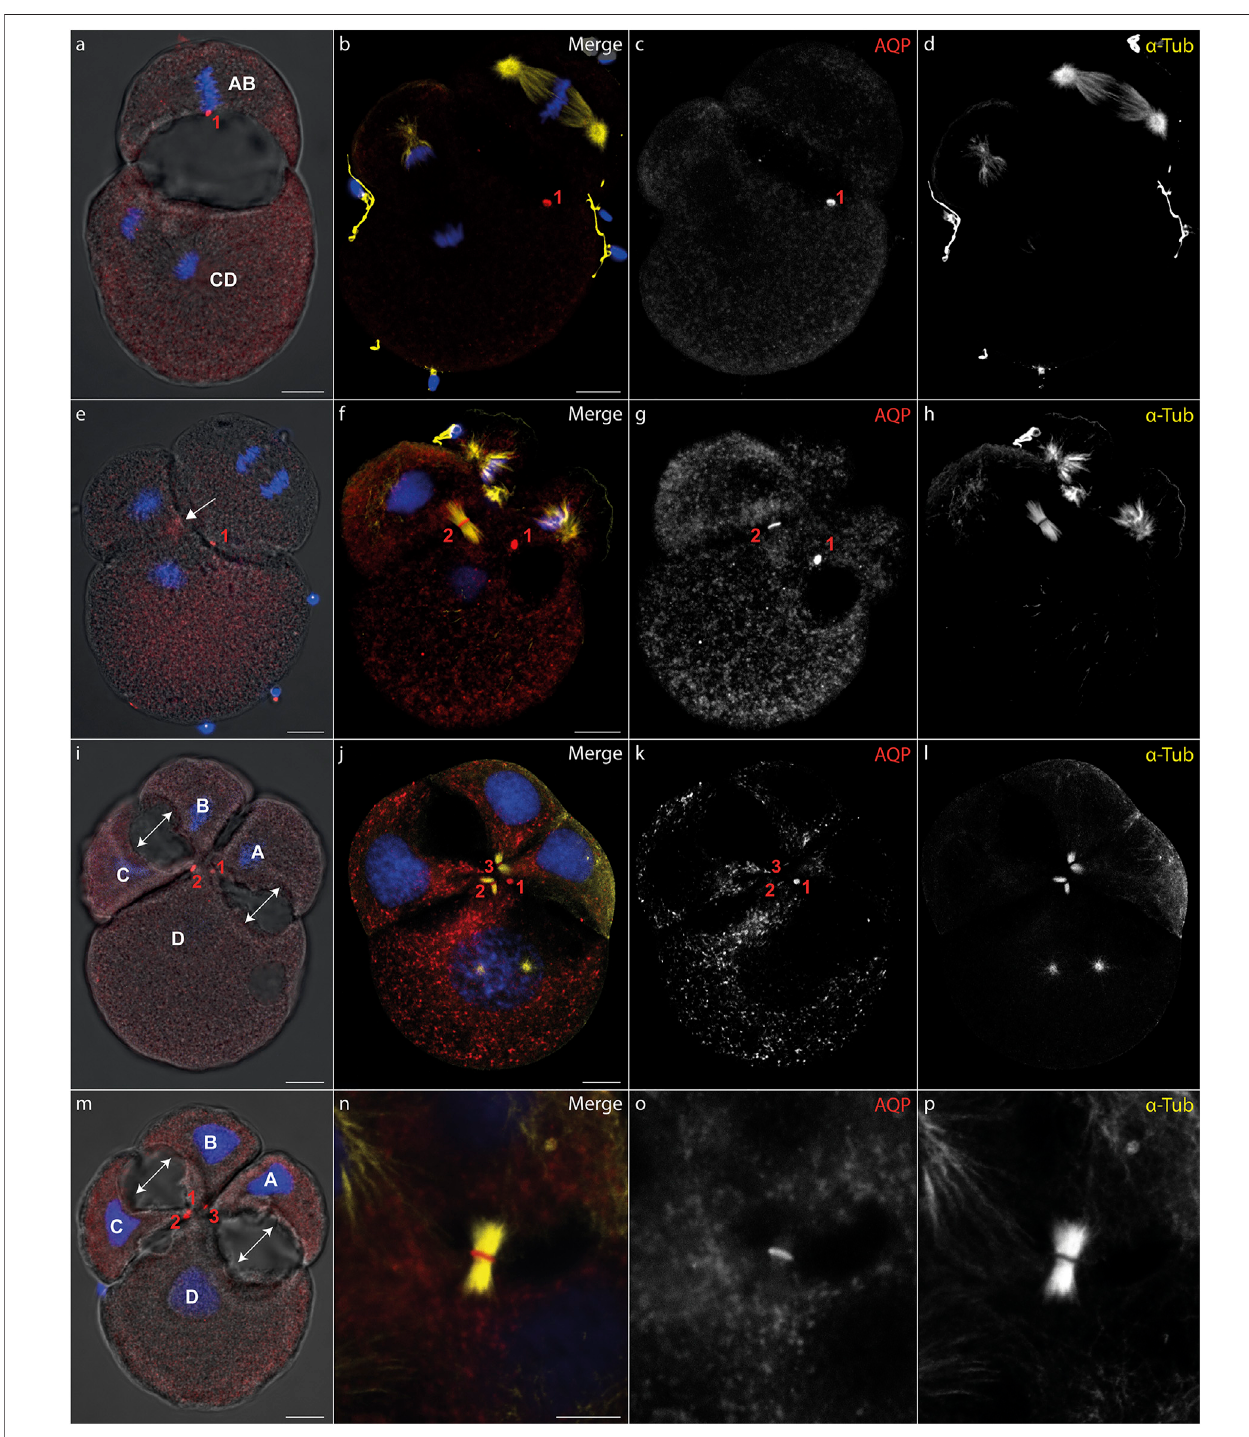
FIGURE 2 | Midbody localization determines the direction of cleavage cavity expansion. (A – P) Maximum intensity projections of Dreissena rostriformis embryos at 1.5hpf (A) ,1.75hpf (B – H) and2hpf (I-P) .Hoechstlabelingofnucleiisshowninblue,Dro-lt-AQP1immuno fl uorescenceisshowninred (A,B,E,F,I,J,M,N) orgrey-scale (C,G,K,O) and acetylated/tyrosinatedalpha-tubulin immuno fl uorescence isshown in yellow (B,F,J,N) or grey-scale (D,H,L,P) . AB and CD blastomere morphology and cleavage cavity expansion are shown in overlays of bright fi eld images with Dro-lt-AQP1 immuno fl uorescence (A,E,I,M) . Midbodies are numbered in the order of theirformationduringthe fi rst(1)andsecondcleavages(2and3).Thearrowin( e )indicatesDro-lt-AQP1accumulationpriortoformationofthesecondmidbodybetween blastomeres C and D. Double-headed arrows in (I,M) indicate the direction of cleavage cavity expansion. (N – O) Close-up of a cytokinetic bridge and Dro-lt-AQP1 immunoreactive midbody. Scale bars, 10 μm.